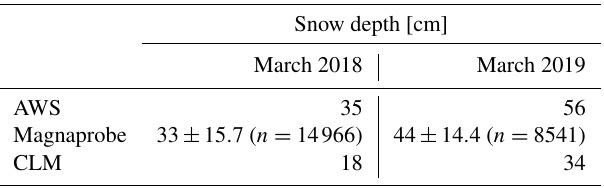
Table 1. End-of-March snow depth summary. Mean and stan- dard deviation of spatially distributed measurements with a sam- ple size greater than n = 1 are shown; otherwise the daily value for 31 March is